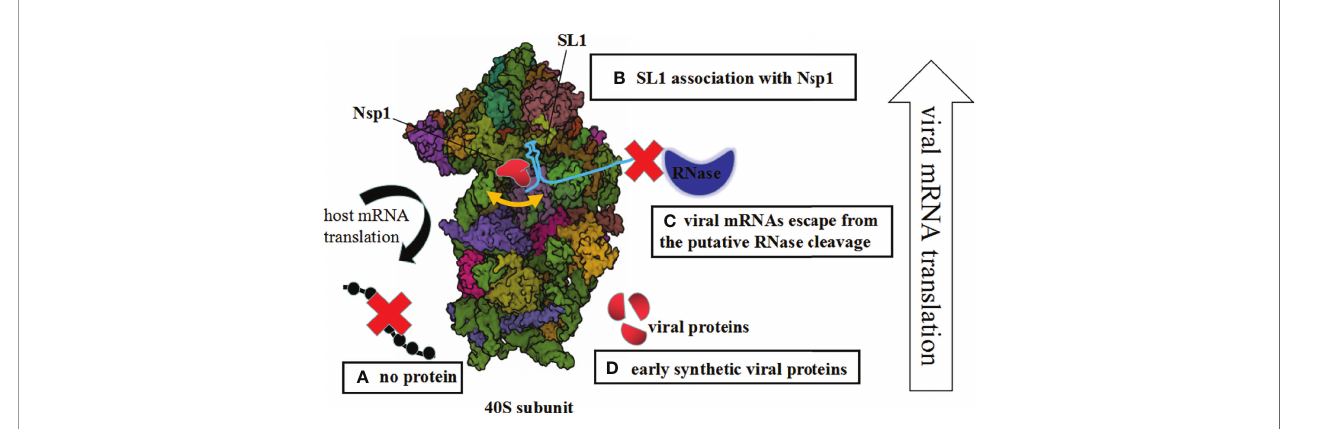
FIGURE 1 | Mechanisms of Nsp1-mediated control of the host and viral gene expression. (A) The host mRNA translation is inhibited due to blocking of the access to mRNAs. (B) Upon interaction between Nsp1 and 5 ′ UTR of the SARS-CoV-2 genome, the mRNA channel is opened. (C) The unusual Nsp1 – 40S complex cannot interact with viral mRNAs, so the viral mRNAs escape from the putative RNase cleavage. (D) Early synthetic viral proteins are enough to drive the virus